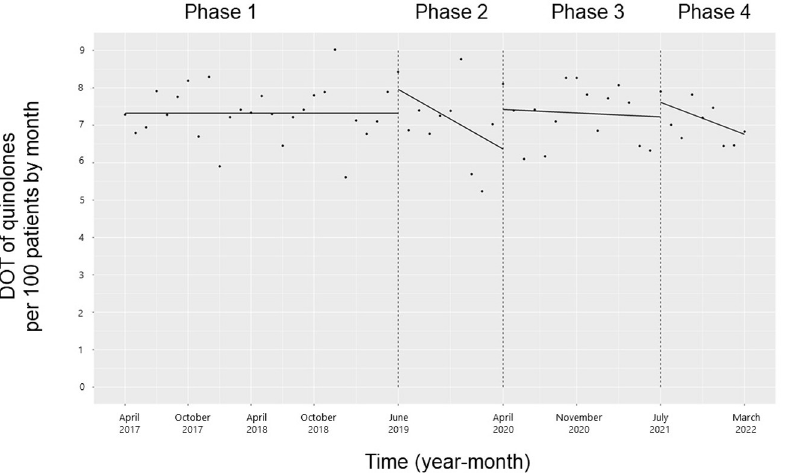
Fig 5. Trends in the days of quinolone therapy per 100 patients, by month, during Phases 1 to 4. Each dot refers to the quinolones per 100 patients in each month, and the slope is based on the linear regression in the four phases: Phase 1 (pre-intervention period from April 1, 2017, to May 31, 2019); Phase 2 (review of clinical pathways from June 1, 2019, to March 31, 2020); Phase 3 (establishing an ID consultation service and implementing the ASP from April 1, 2020, to June 30, 2021); and Phase 4 (educational lecture and pop-up displays for oral antimicrobials from July 1, 2021, to March 31, 2022).